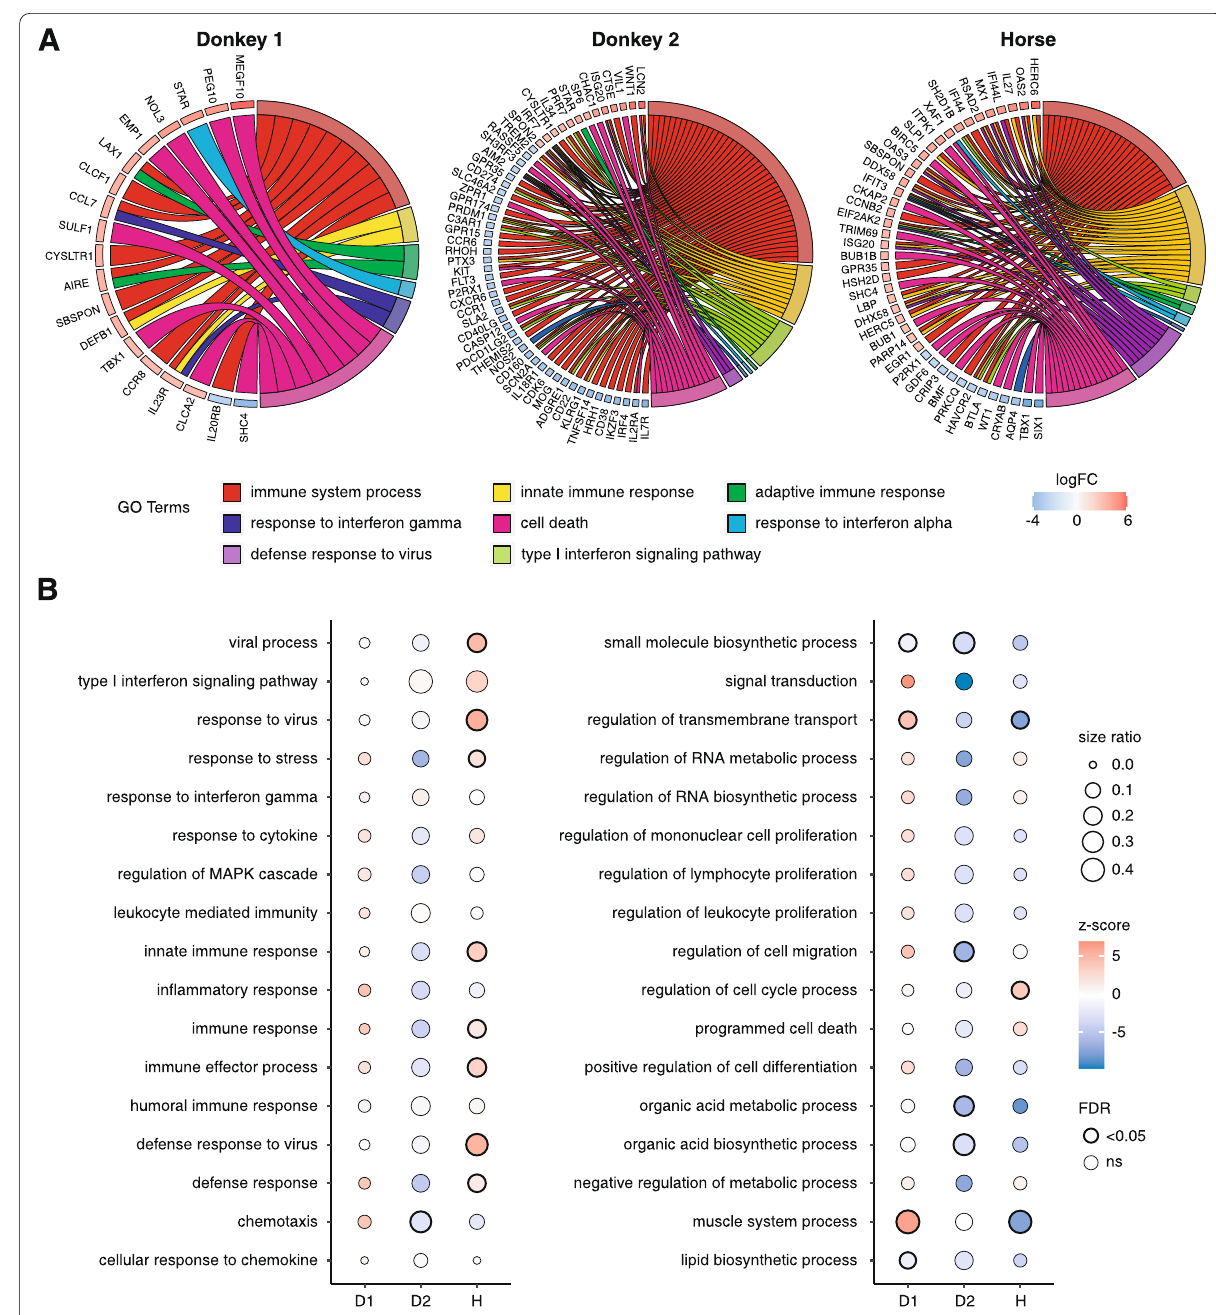
Fig. 4 Analysis of immune signatures in donkeys and the horse. A Chord plots depicting the 250 most de-regulated genes for each animal and their contribution to the (de-)activation of immune system processes. B Regulation of selected GO-terms. The dot color reflects whether a term is up- or down-regulated (z-score). The size ratio indicates the number of deregulated genes per term and the dot border is a binary indicator for a significant (FDR < 0.05) =